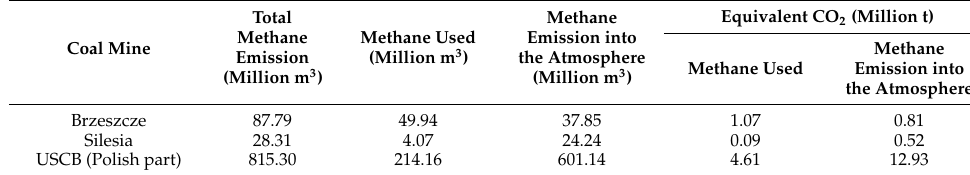
Table 4. Methane emissions from the Brzeszcze and Silesia mines, and total USCB in 2021, according to